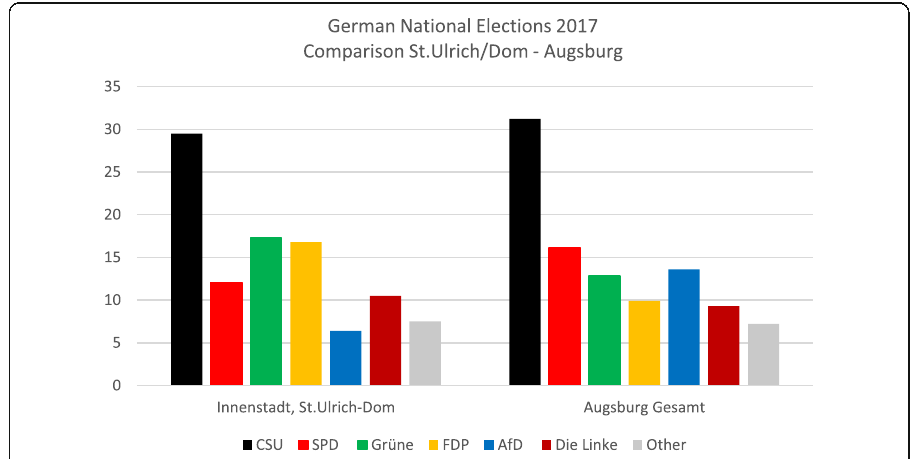
Fig. 1 Voting behaviour of area (inner city district, section ‘ St.Ulrich/Dom ’ , Ger. ‘ Innenstadt ’ ) in comparison to the total results for Augsburg (Ger. ‘ Augsburg Gesamt ’